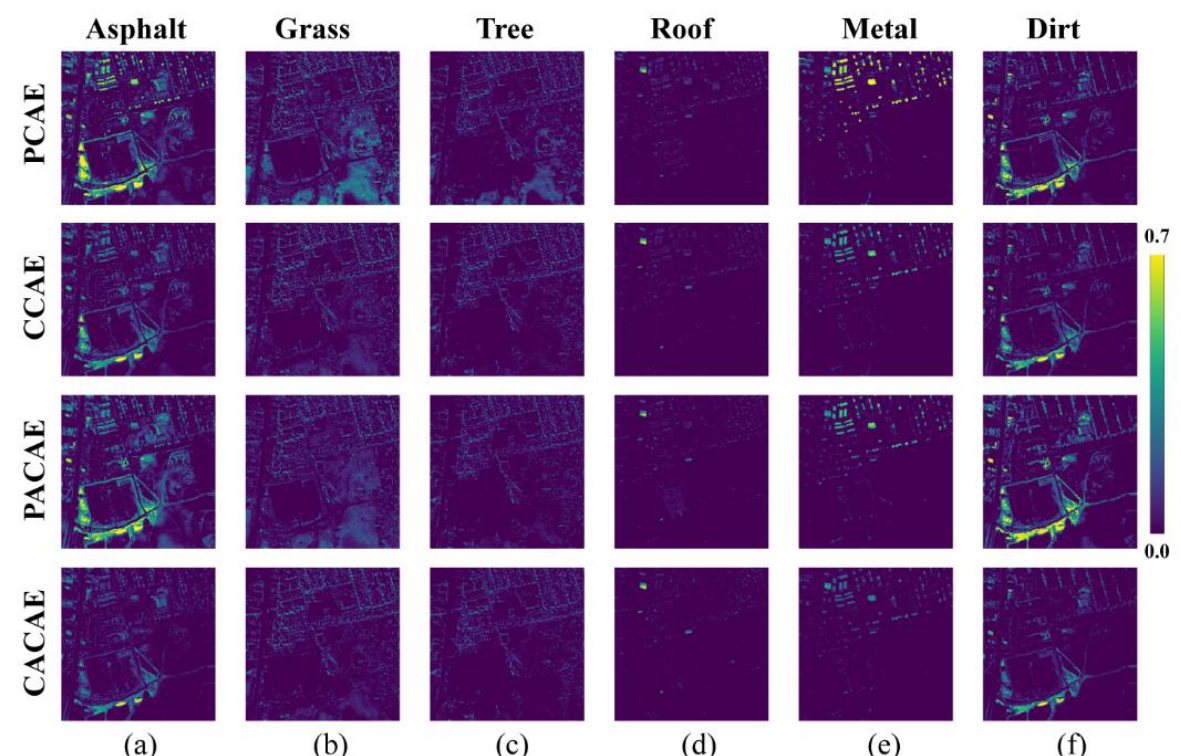
dataset. (a) Asphalt; (b) Grass; (c) Tree; (d) Roof; (e) Metal; (f) Dirt. dataset. ( a ) Asphalt; ( b ) Grass; ( c ) Tree; ( d ) Roof; ( e ) Metal; ( f ) Dirt.